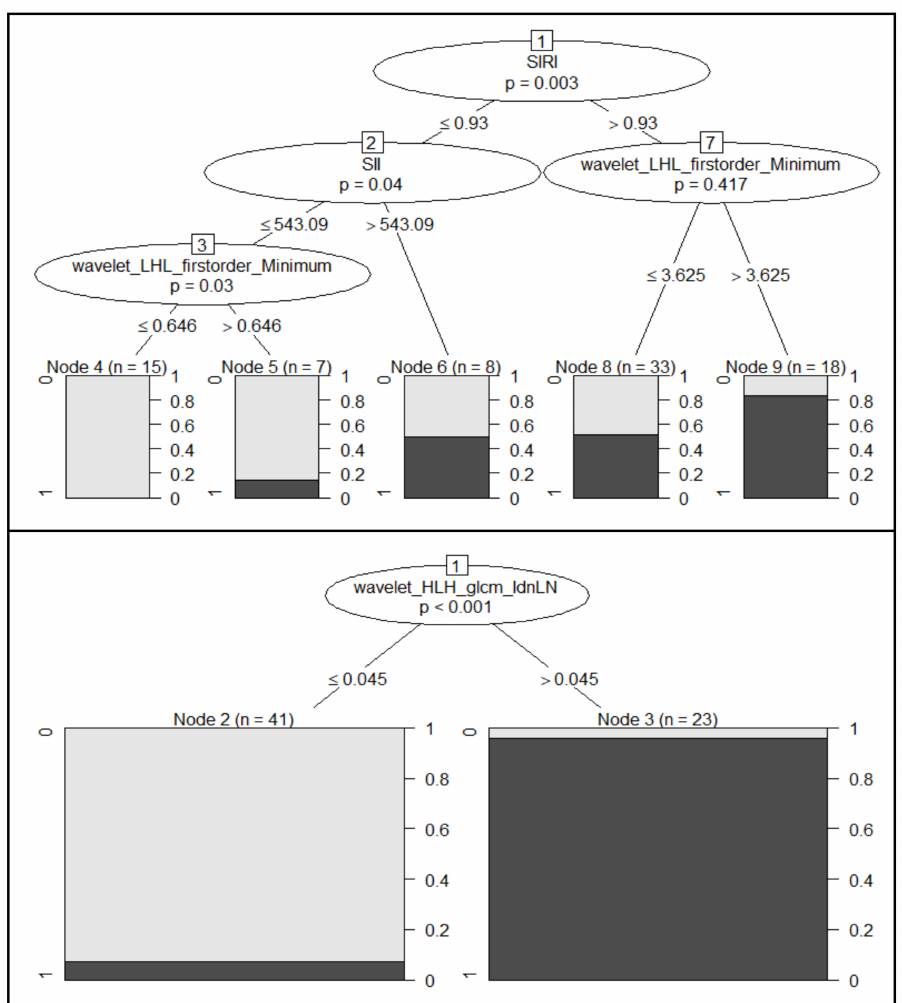
Figure 2. Decision trees obtained with the CIDT algorithm for the prediction of tumor grading ( top panel) and metastatic lymph nodes ( bottom panel). For each inner node, the Bonferroni-adjusted p -values are given, while the fraction of responsive patients is displayed for each terminal